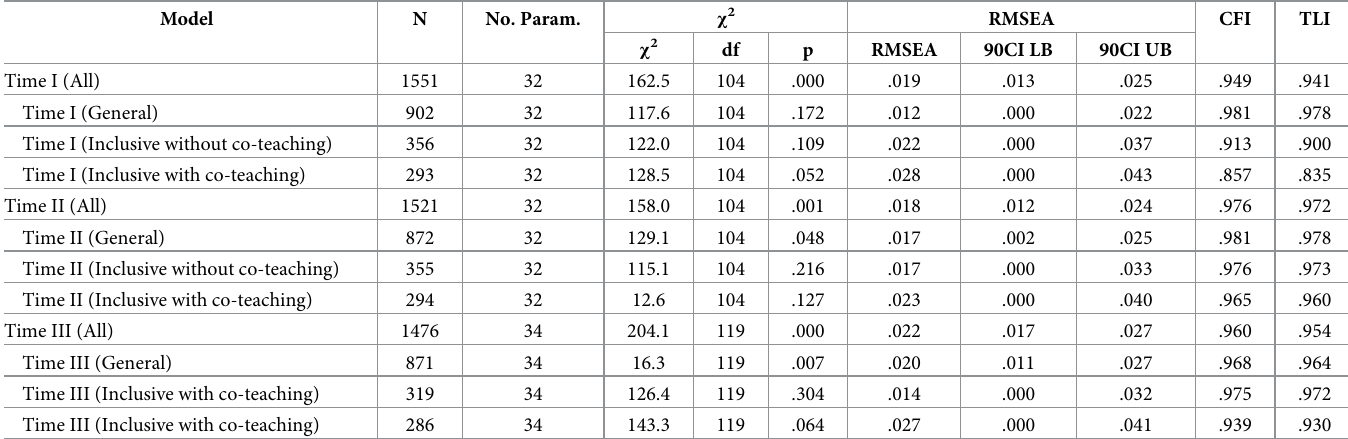
Table 5. Fit indices for results in mathematics. Model